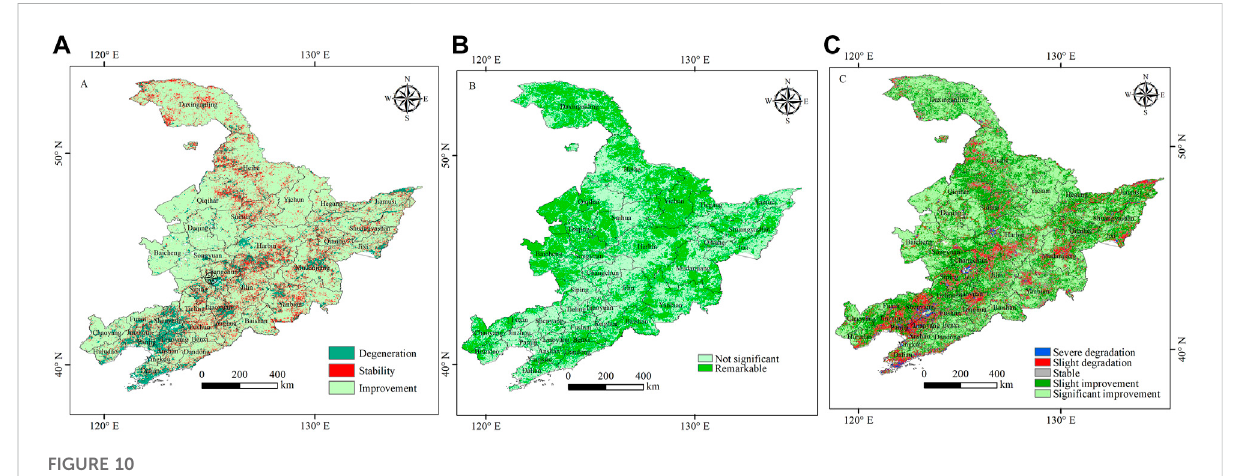
FIGURE 10 NDVI change trend of vegetation in the three northeast provinces (A – C)